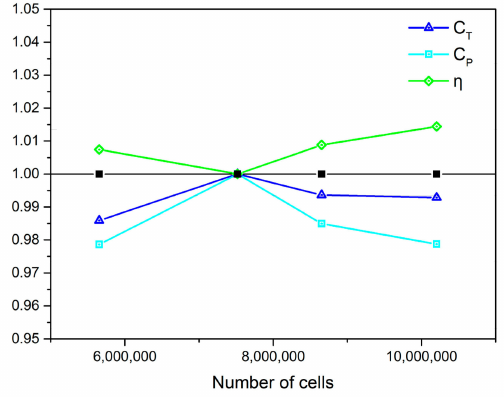
Figure 15. Mesh independency